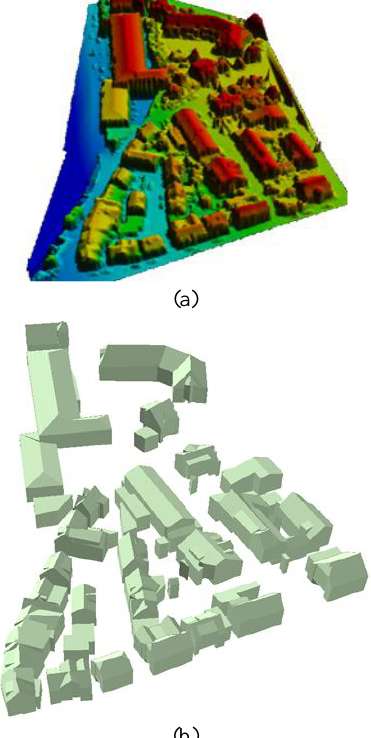
Figure 6. 3D building reconstruction results in the whole test area: (a) LiDAR data and (b) 3D fine building